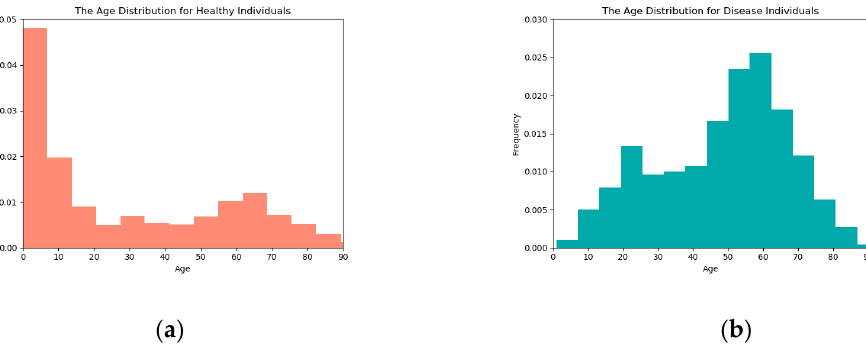
Table 7. Results of GBR and Multiple Linear Regression on saliva samples.